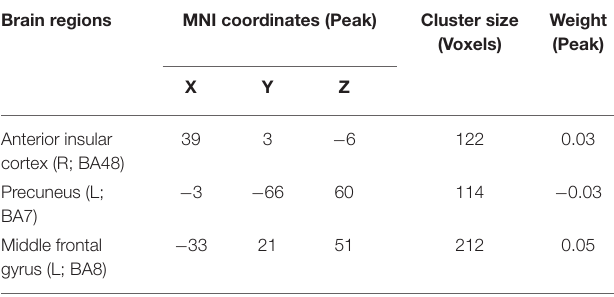
TABLE 2 | Top one percent of the region weights from SVM classifier using the functional connectivity